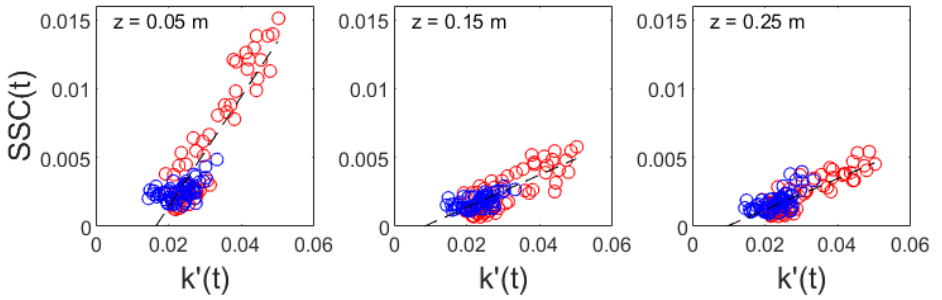
Figure 17. Ensemble-averaged sediment concentrations at (nominally) z = 0.05, 0.15 and 0.25 m, as a function of ensemble-averaged Froude-scaled turbulent kinetic energy. Red color: Plunging breakers, blue color: spilling breakers. The relationships have coefficients of determination, r 2 = 0.81, 0.63, 0.67, respectively. Reproduced from Aagaard et al. [72].